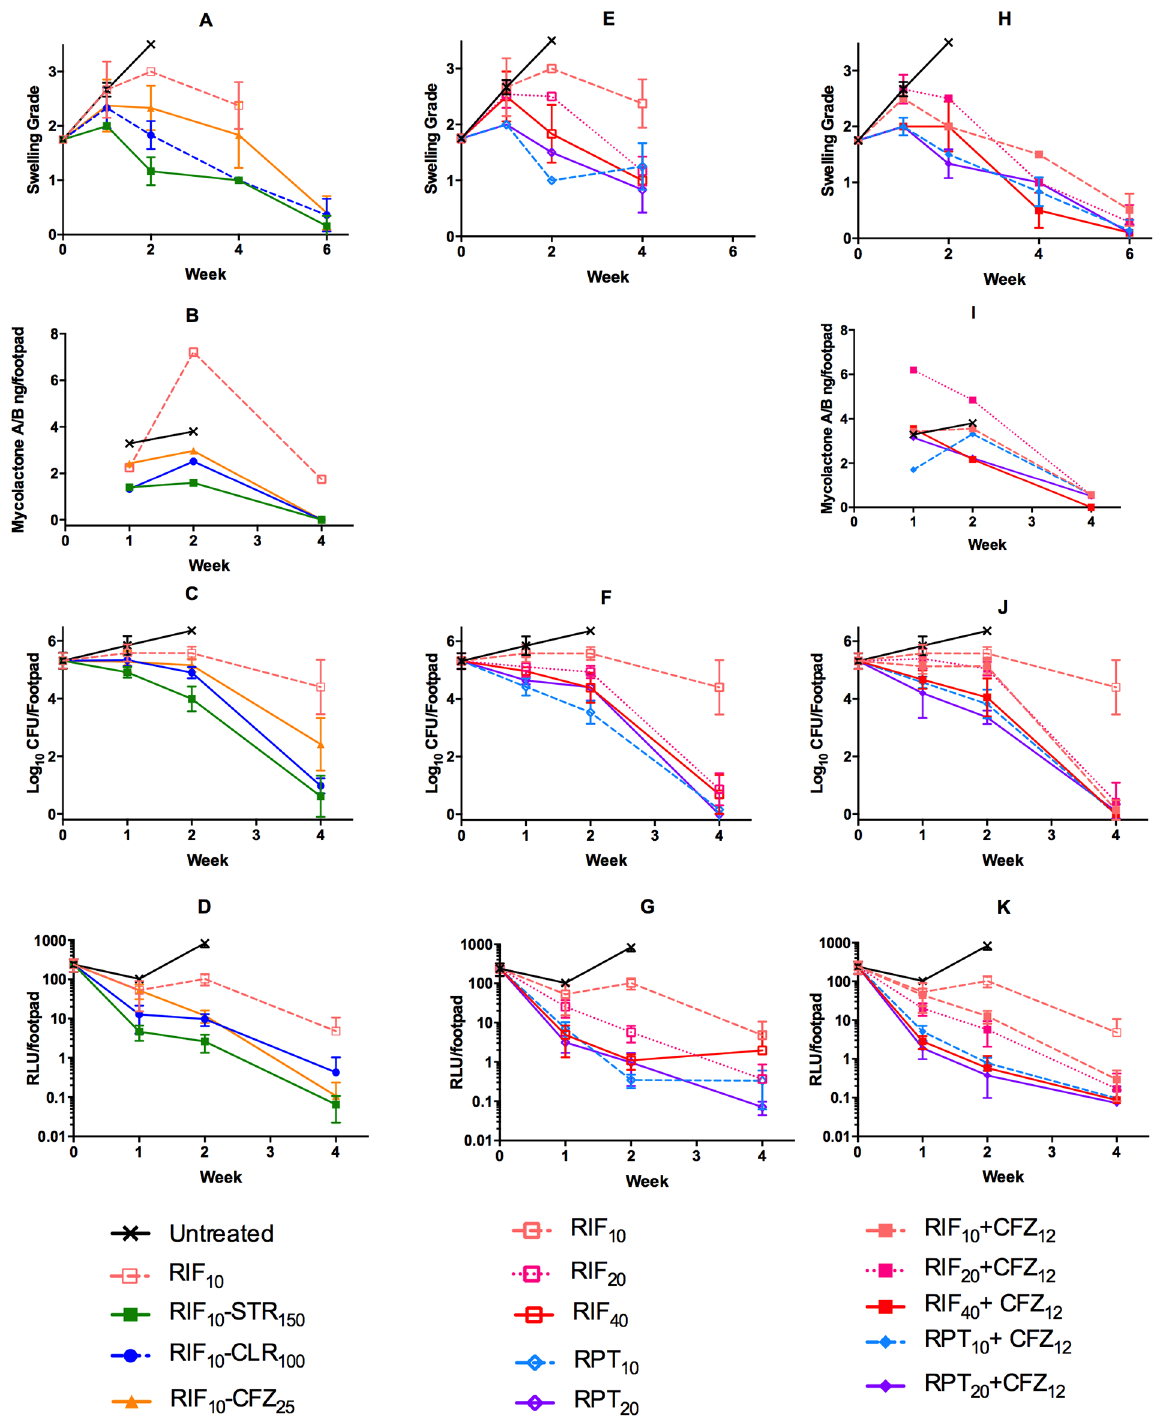
Fig 1. Response to treatment in M . ulcerans -infected mice treated with rifampin or rifapentine monotherapy at different doses or with standard-of-care regimens or regimens combining high-dose rifamycins with clofazimine. Mice were infected with M . ulcerans 1059AL. After 5 weeks the swelling grade was nearly 2 on a scale of 0–4 before treatment initiation (D0) with RIF monotherapy at the dose of 10 mg/kg (RIF 10 , open light red squares, dashed lines). Control mice were left untreated (x). Control combination regimens were RIF 10 plus STR (150 mg/ kg, green solid squares), CLR (100 mg/kg, blue solid circles), or CFZ (25 mg/kg, orange solid triangles). High-dose rifamycin monotherapy regimens included: RIF at 20 mg/kg (RIF 20 , open red square, dotted line) or 40 mg/kg (RIF 40 open red square, solid line), or rifapentine at 10 mg/